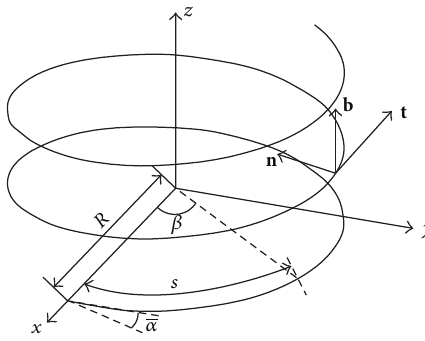
Figure 2: Geometry of a typical cylindrical helical spring.